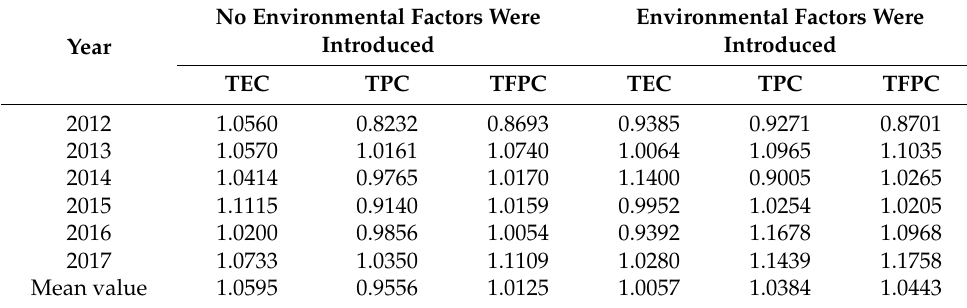
Table 3. Port TFP index and its decomposition term